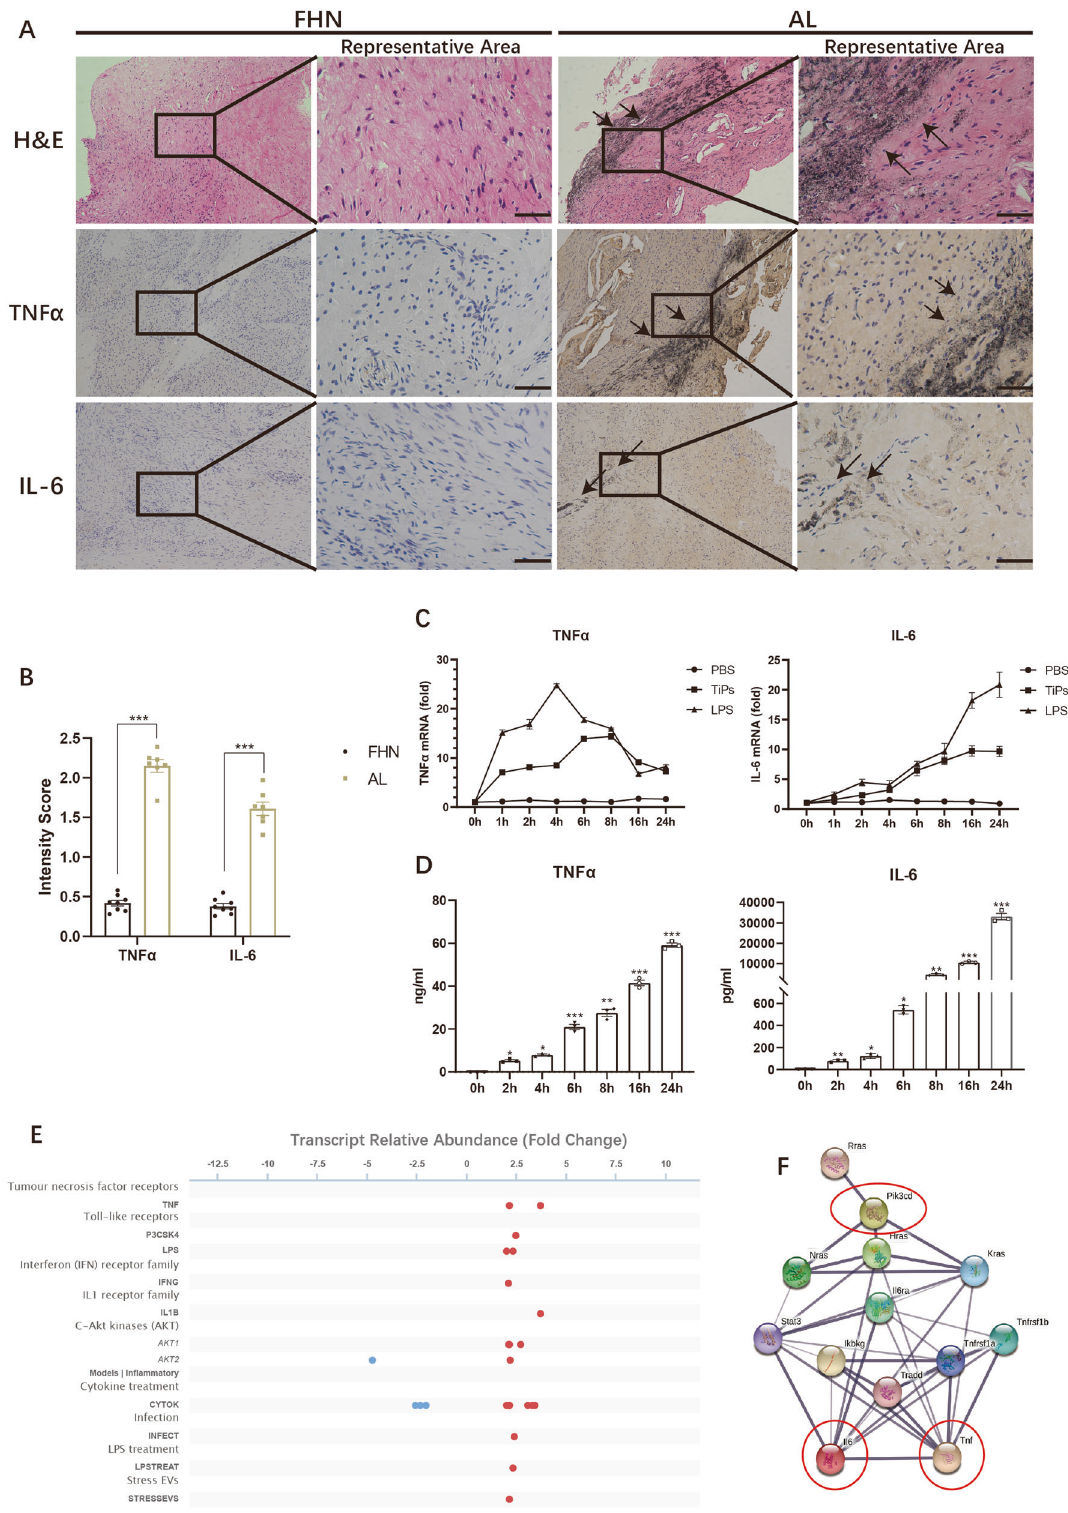
TiPs activated NF- κ B pathway and M1/M2 macrophages polariza- tion ratio. In vivo experiments, the role of KLF4 and p110 δ were further con fi rmed in TiPs-induced mice cranial osteolysis, suggesting p110 δ as a pro-osteolysis factor while KLF4 was an anti-osteolysis